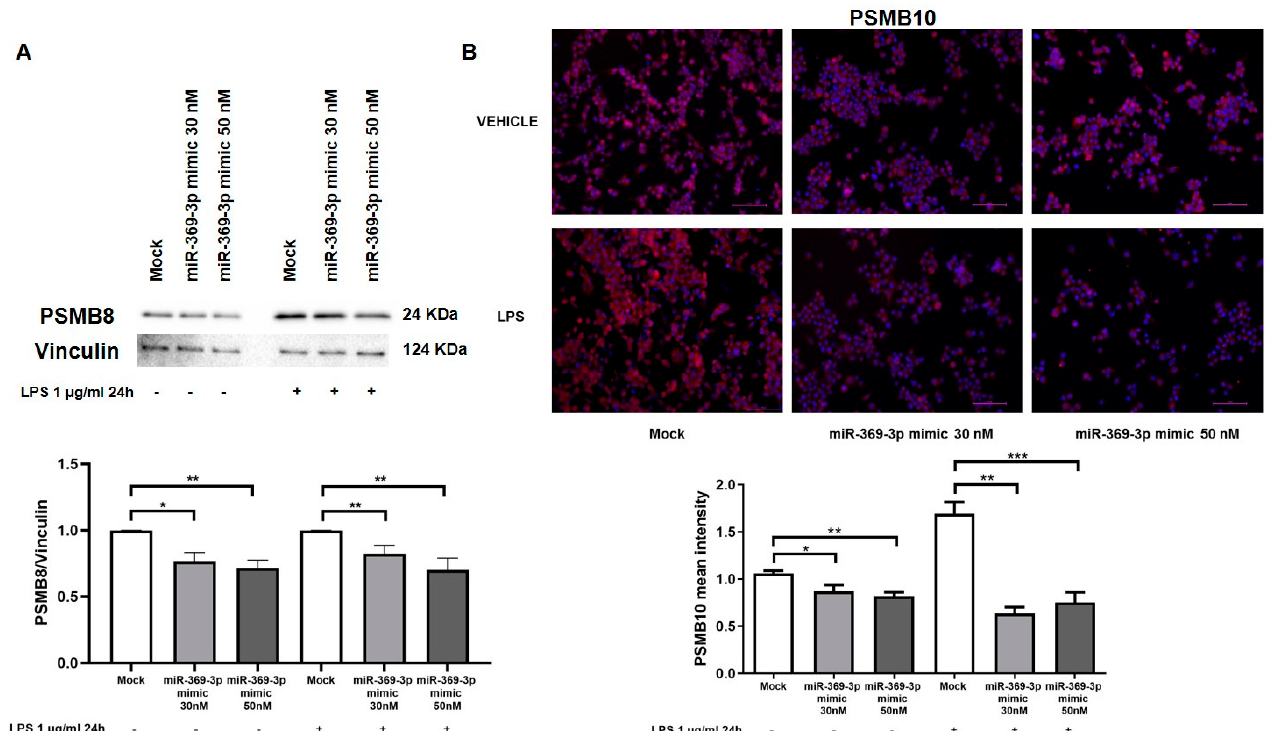
Figure 3. Modulation of PSMB8 and PSMB10 protein expression by miR-369-3p in RAW264.7 cells. ( A ) Western blot analysis of PSMB8 protein expression after miR-369-3p mimic transfection in RAW264.7 cell line unstimulated and LPS-stimulated. The miR-369-3p transfection led to a significant decrease in PSMB8 in LPS-unstimulated as well LPS-stimulated samples. Vinculin was used as housekeeping protein to normalize the data. Data were obtained by comparing normalized sample values to the normalized mock sample value. ( B ) Immunofluorescence staining of PSMB10 in RAW264.7 cell cultures after miR-369-3p mimic transfection. PSMB10 mean intensity was quantified on nuclei number as the mean of three images per cell slide. Original magnification, ×20. Scale bar presents 50 μ m. * p < 0.05; ** p < 0.01; ***p<0.001.